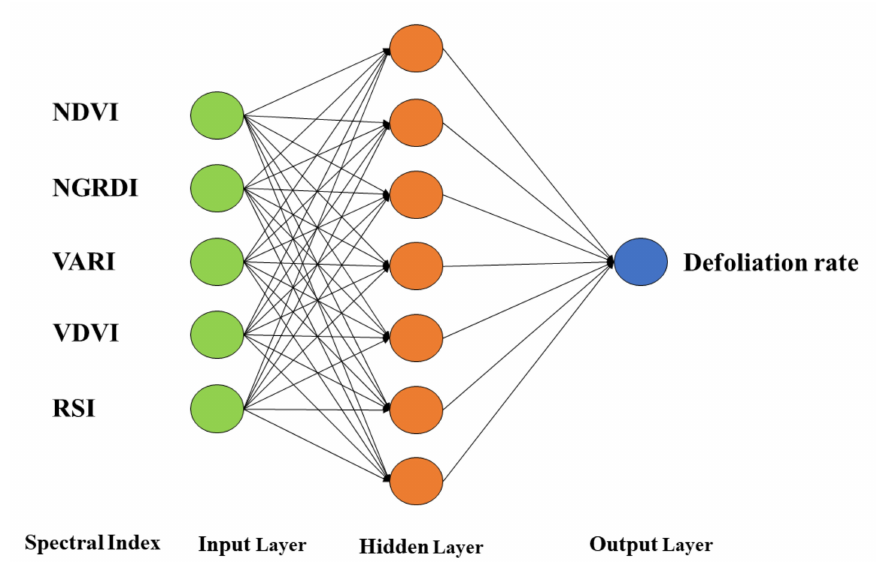
Figure 6. BP neural network structure of this study.